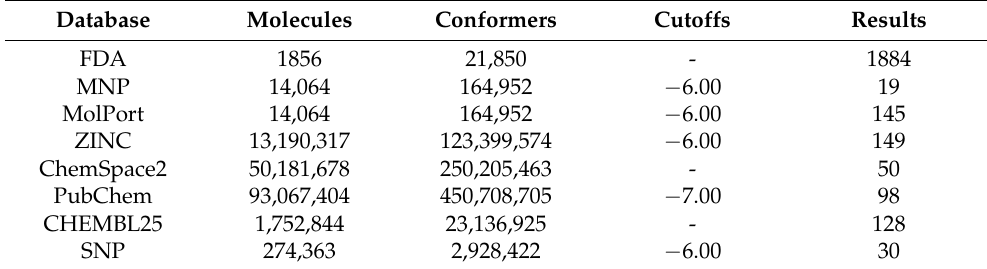
Table 1. Screened databases, cutoffs and